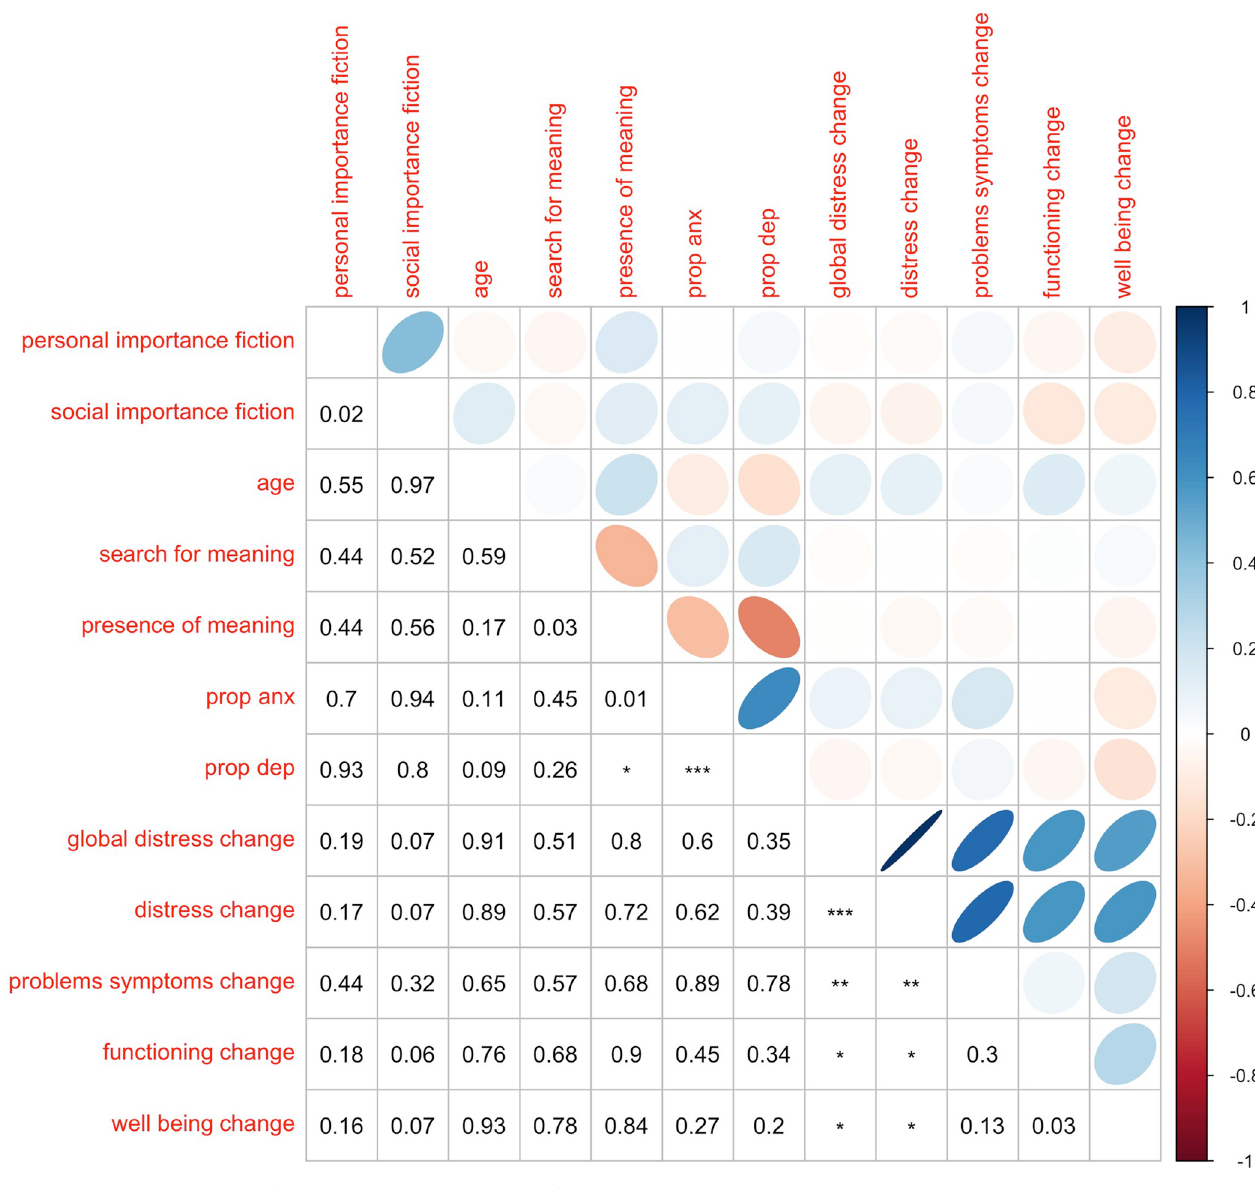
Fig 3. Variable correlation table ( � p < .01; �� p < .001; ��� p <